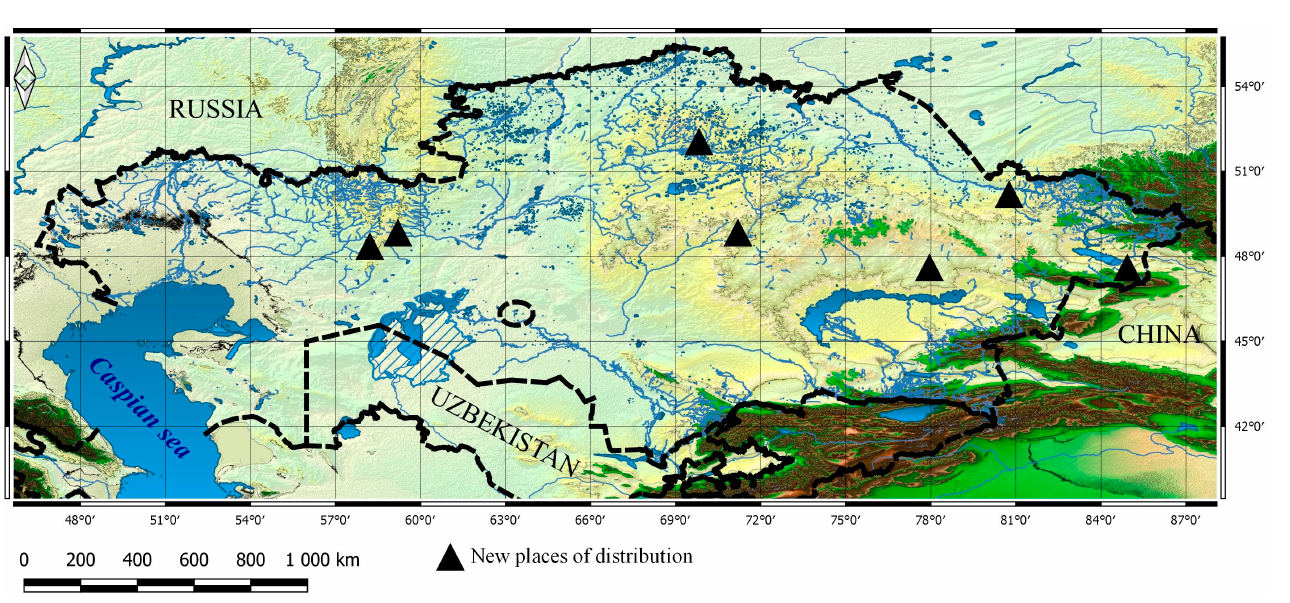
Figure 6. Distribution of Dactylorhiza umbrosa (Kar. and Kir.) Nevski in Kazakhstan. 3.2.4. Dactylorhiza magna (Czerniak.) Iconn., Nov. Syst. Visch. Rast. 9:303 (1972). ≡ Or-